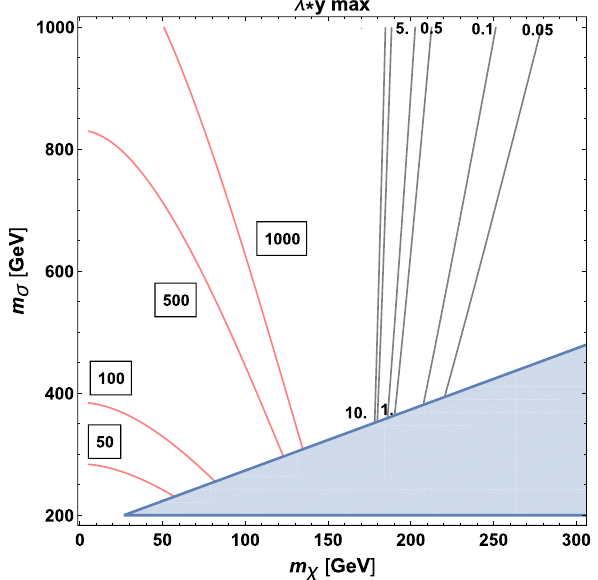
Fig. 7 Upper bound on λ y , represented in the ( m σ , m χ ) plane derived from the width of the χ fermion and the top quark. The black contours correspond to a minimum decay length for the invisible χ of 10 metres, while the red ones correspond to a new physics contribution to the top width of about 5 GeV Assuming that the Standard Model width is unaffected